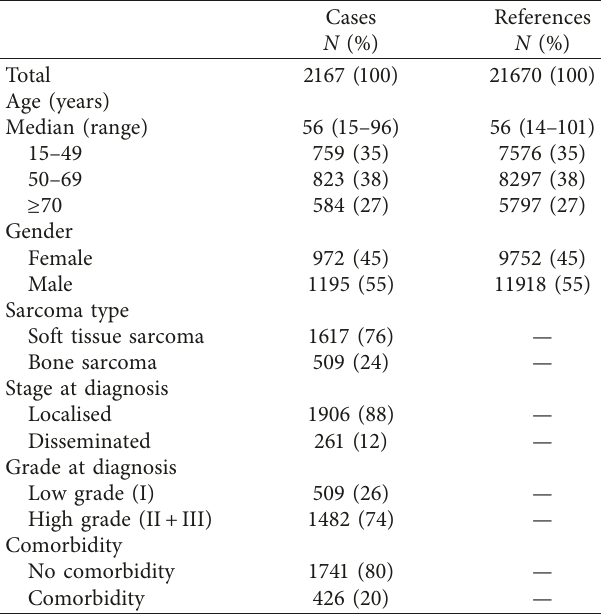
Table 1: Patient characteristics for 2167 sarcoma patients di- agnosed from 2000 to 2013 in Denmark and 21,670 references matched on age, gender, and general practice.